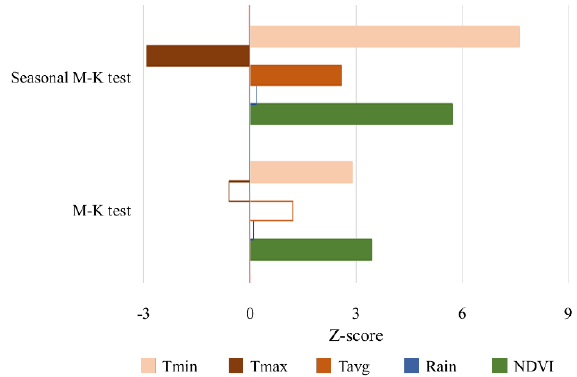
Figure 3 M-K test and Seasonal M-K test of